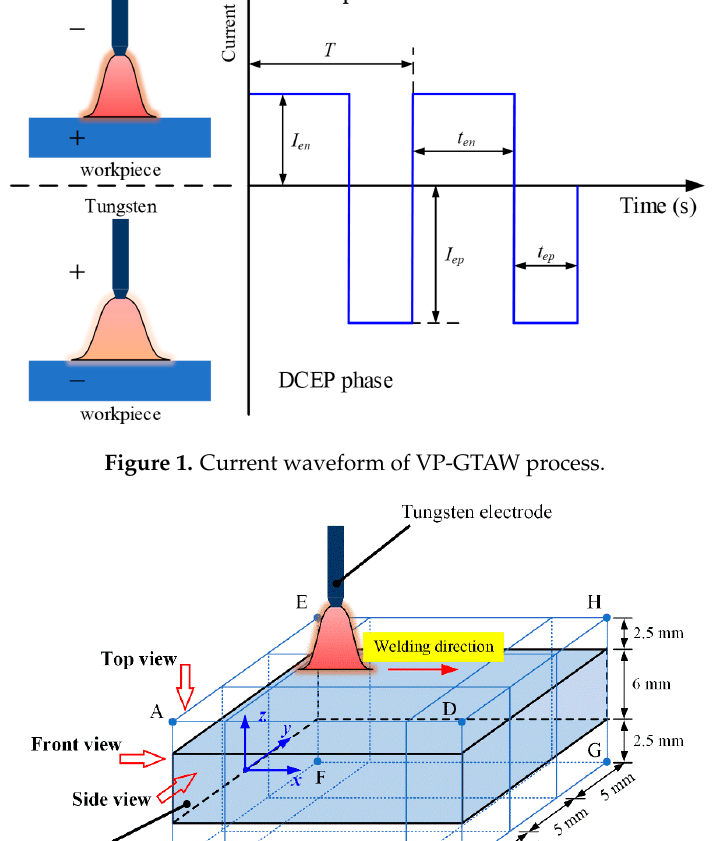
Table 3. Thermo-physical properties of 2024 aluminum alloy and other process variables.